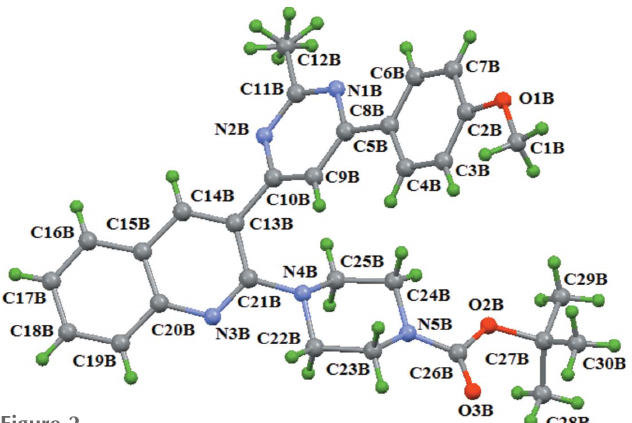
Figure 2 The molecular structure of molecule B showing 30% probability displacement ellipsoids.